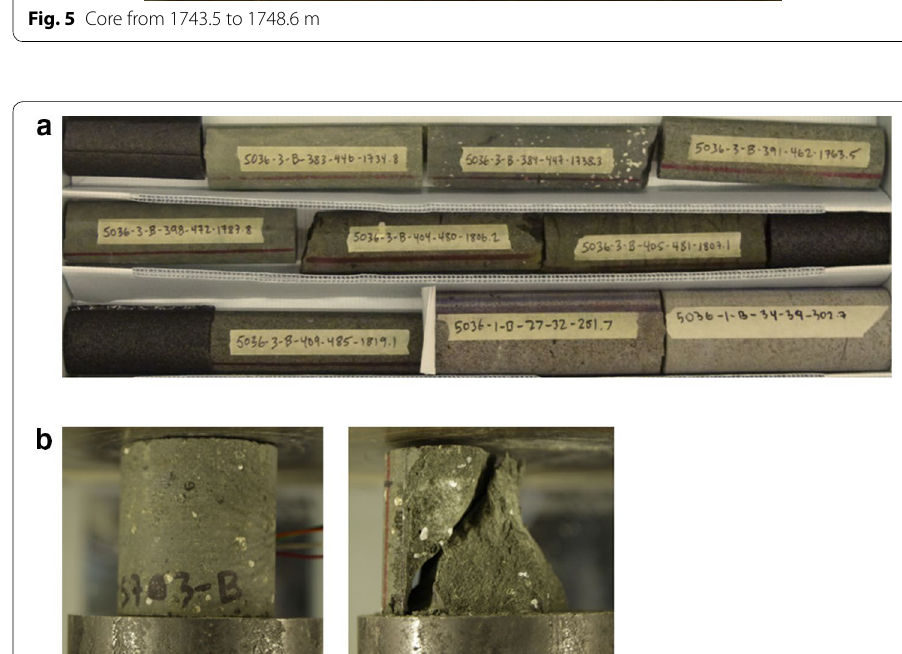
Fig. 6 Pictures of Unit 1: a core; b sample before and after UCS